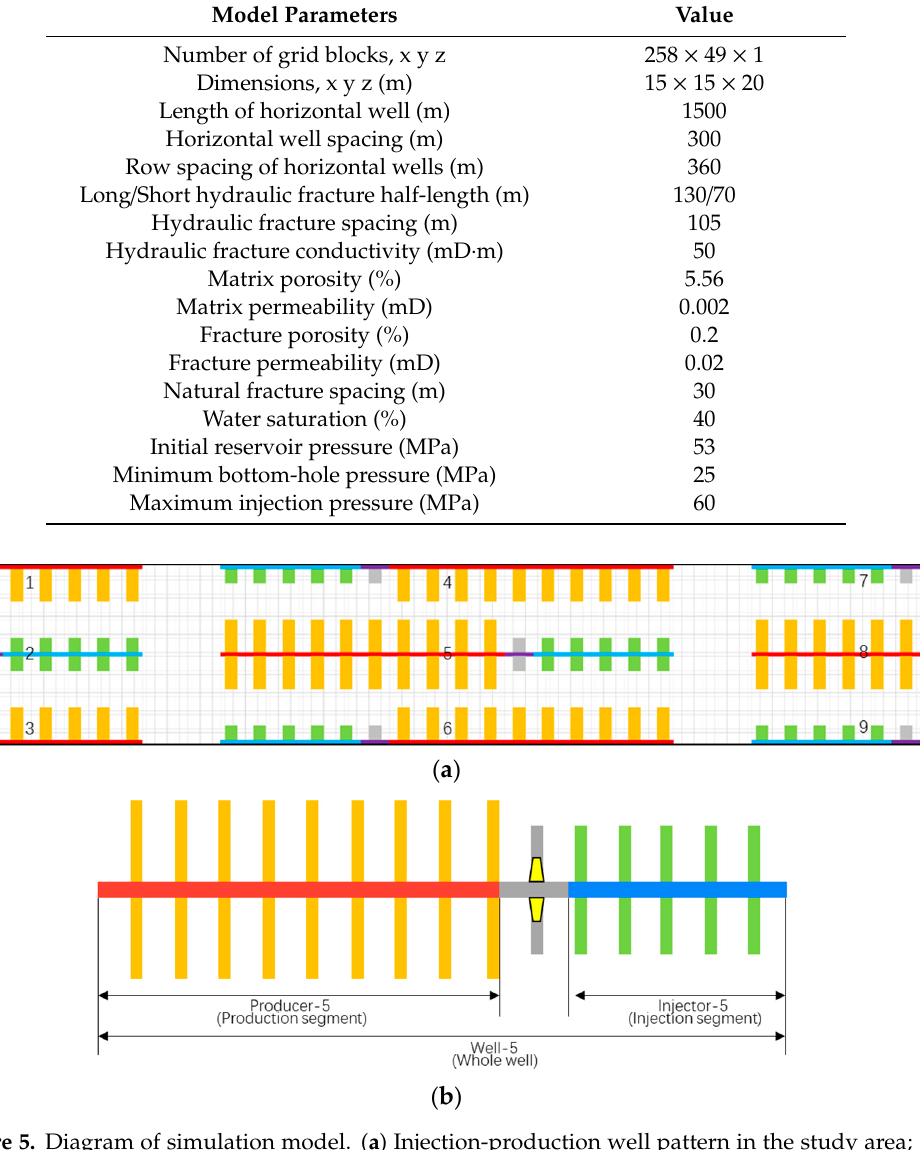
Table 3. Numerical simulation model parameters. Model Parameters 60 Table 4. Parameters for the Log Grid Refinement (LGR) method. Parameters